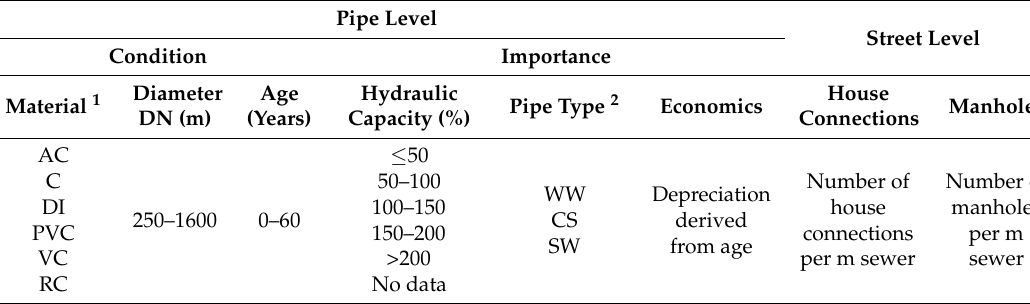
Table 1. Influencing factors for the sewer